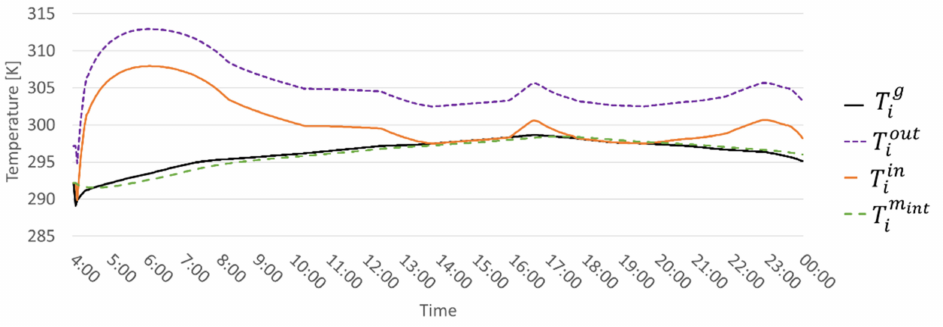
Figure 4. State and additional variables associated with the temperature in the MPC approach. The optimal tracking of the temperature set points along the time horizon is displayed.